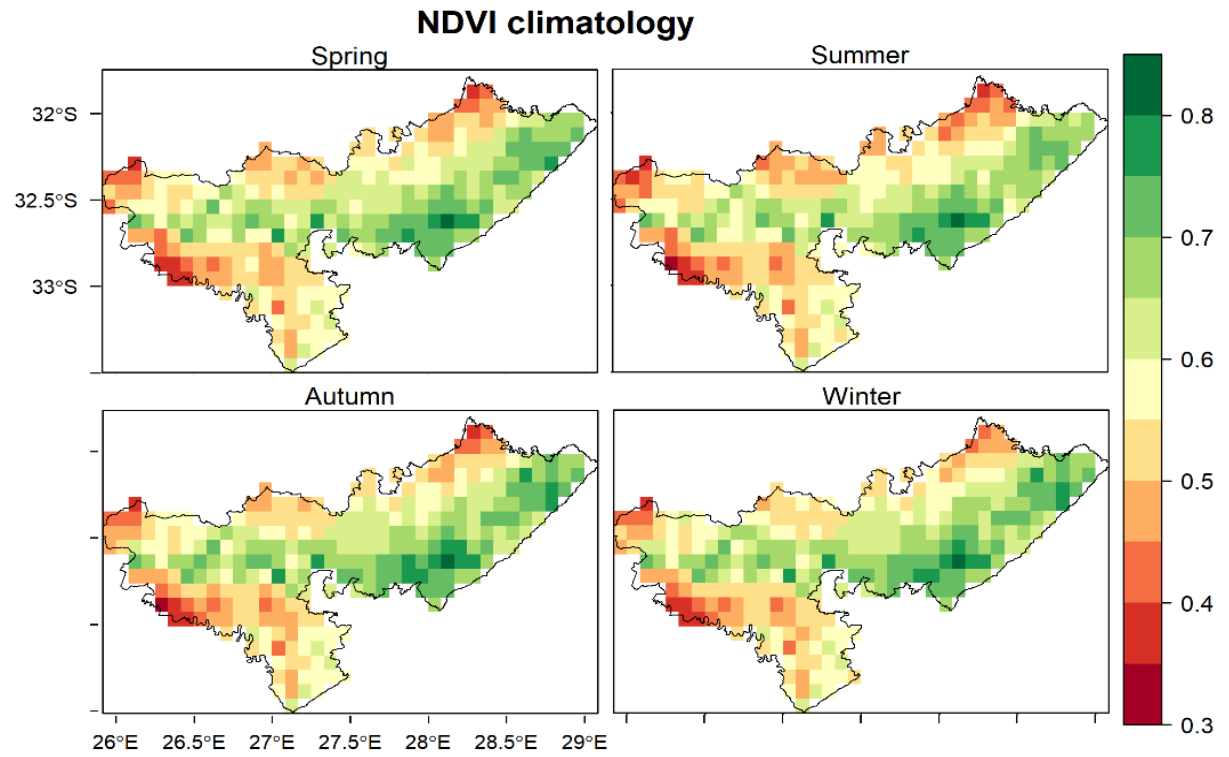
Figure 2. Spatial and seasonal characteristics of third-generation Global Inventory Modeling and Mapping Studies (NDVI3g climatology) (1981–2015) for Amathole District Municipalities.